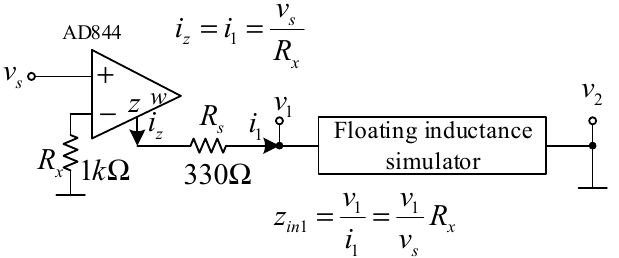
Figure 32. Experimental setup used to measure the input impedance at the first port ( v 1 ).